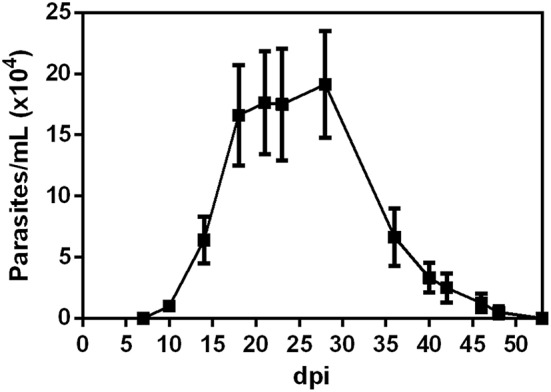
Parasitemia development. Male BALB/c mice were infected with 5 × 104 insect-derived metacyclic forms of T. cruzi within the oral cavity. Parasitemia (mean and SEM) was assessed during the acute phase and is expressed as parasites per milliliter. Parasites were counted by light microscopy and parasitemia calculated by the Pizzi-Brener method. n: 7 dpi = 21, 10, and 14 dpi = 15, 18 dpi = 18, 21 dpi = 11, 23 dpi = 6, 28 dpi = 8; 36, 40, 42, 46, 48, and 53 = 4. The total number of animals in each time point was obtained from different experiments.